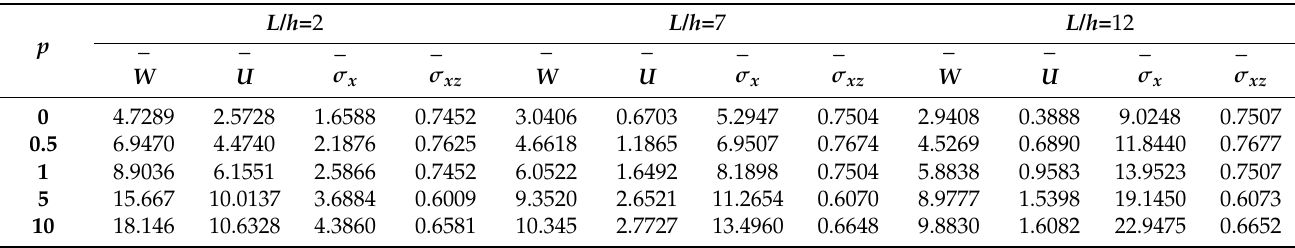
Table 3. Effect of slenderness ratio ( L / h ) and material index ( p ) on non-dimensional transverse and axial displacements, axial and shear stresses of S-S FG beam.